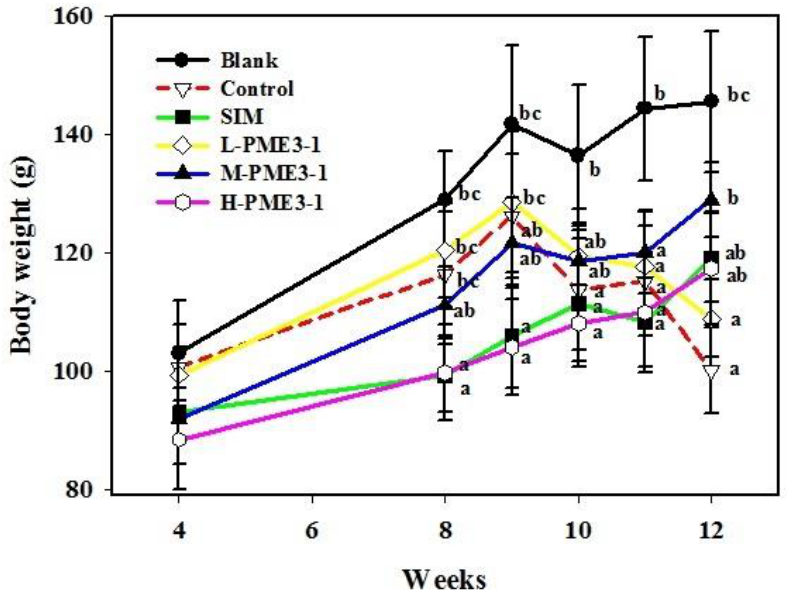
Figure A1. Effects of PME3-1 on the body weight change in hamsters fed with high fat and cholesterol diet. The HFC-diet hamsters were orally supplemented with low (L-PME3-1), middle (M-PME3-1) and high (H-PME3-1) doses of PME3-1 (0.2, 1.0, 5.0 mg/kg b.w.) or Simvastatin (SIM) (5.0 mg/kg b.w.). Body weights were measured once a week. Each value is expressed as mean ± standard deviation (n = 8). Value (a – c) with different letters within different groups at the same week indicates significant difference ( p < 0.05).